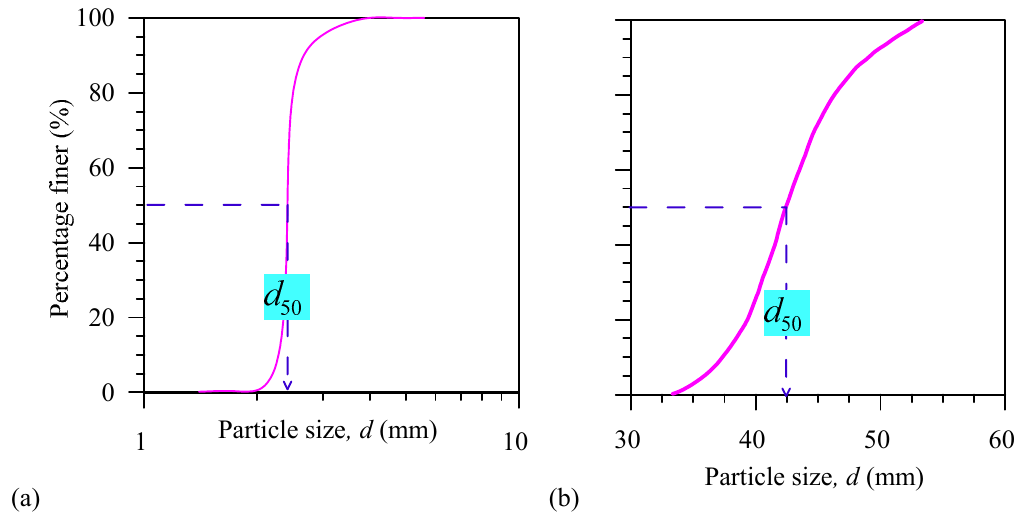
Figure 4. Particle size distribution curve for ( a ) the sand-bed (Run 1 and Run 2) and ( b ) the gravel-bed material (GB 1).